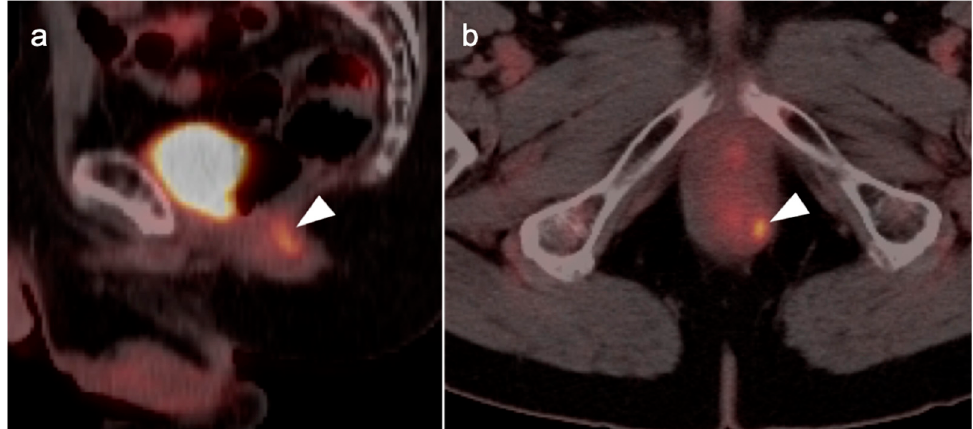
Figure 42. Inflamed internal hemorrhoid (white arrowhead) is hypermetabolic, and may assume a short linear configuration, as shown in this case on sagittal ( a ) and axial ( b ) fused FDG PET-CT images of the pelvis. Inflamed internal or external hemorrhoids can mimic anal cancer.